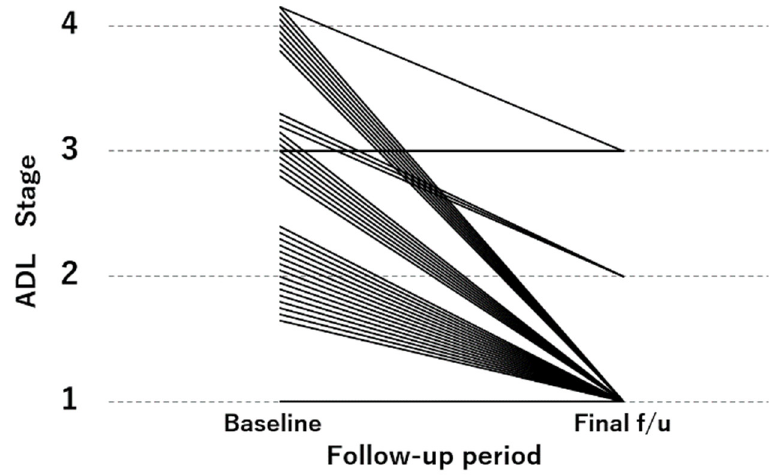
Figure 2. ADL at the baseline and at the final follow-up. Final f/u: final follow-up.